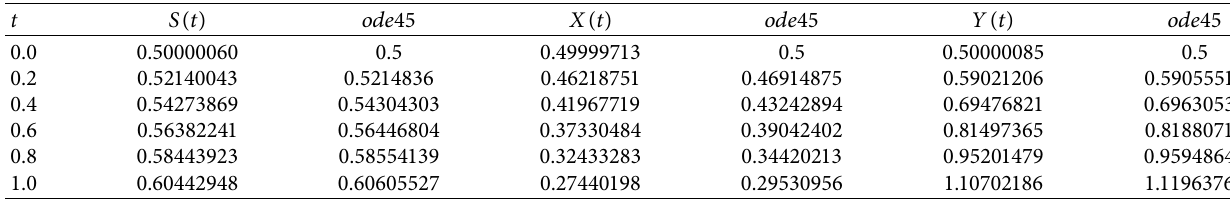
Figure 9: Comparison between solutions obtained by the LeNN-WOA-NM algorithm under the influence of variations in β densities of the prey-predator model. (a) Approximate solutions for population density of local prey. (b) Approximate solutions for population density of immigrant prey. (c) Approximate solutions for population density of the predator. Table 21: Comparison between solutions obtained by the LeNN-WOA-NM algorithm and ode45 for the prey-predator model with � 0 . α 2